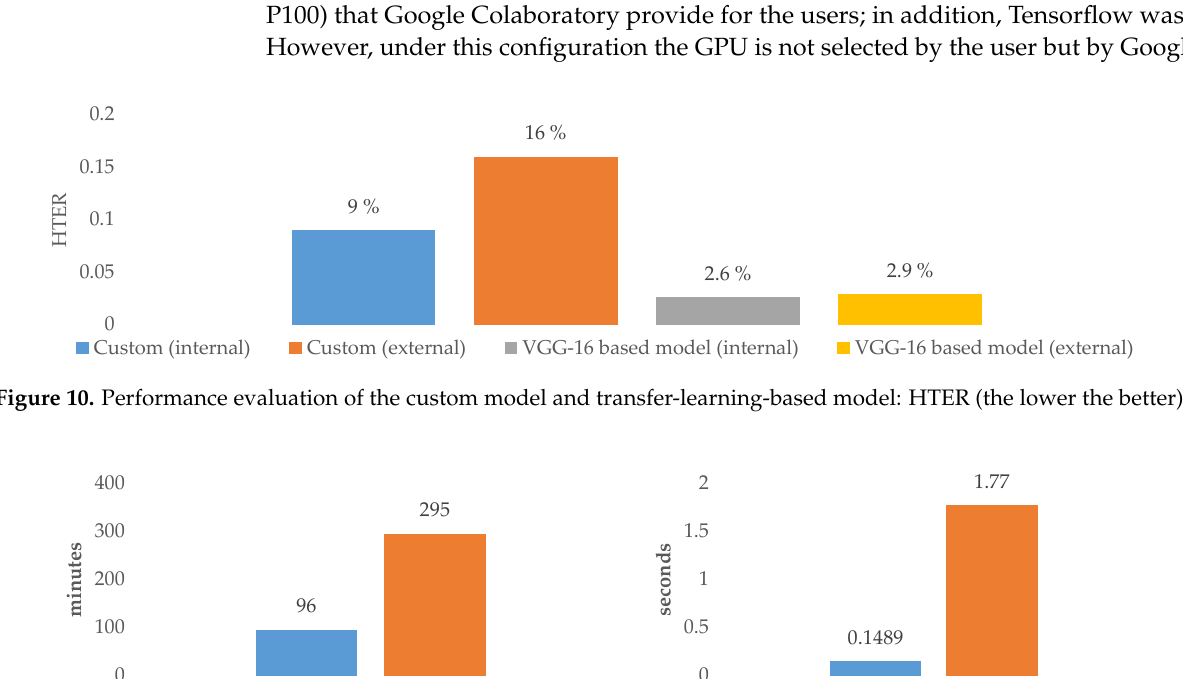
Figure 9. Performance evaluation of the custom model and the transfer-learning-based model: P, R, and F1-score (the